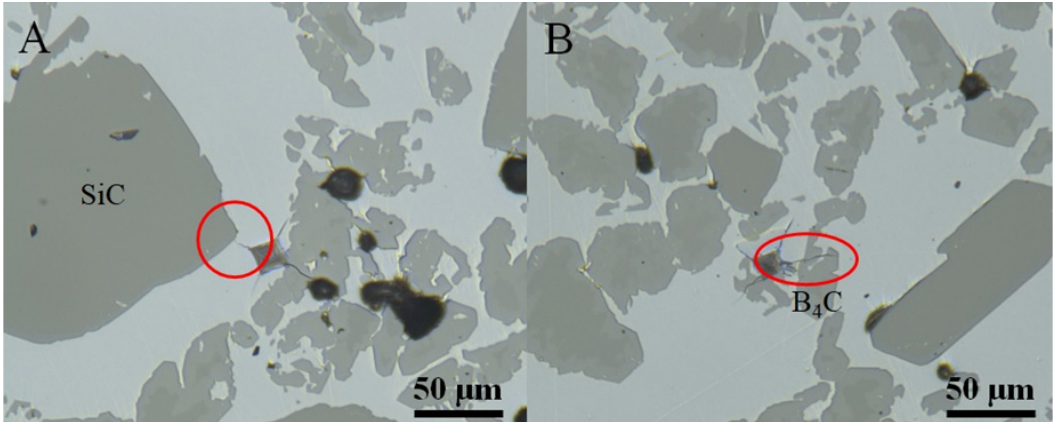
Figure 12. Optical image of the SiC-B 4 C-Si composite showing matrix and particle interface behavior through crack propagation from Vickers microhardness indents.